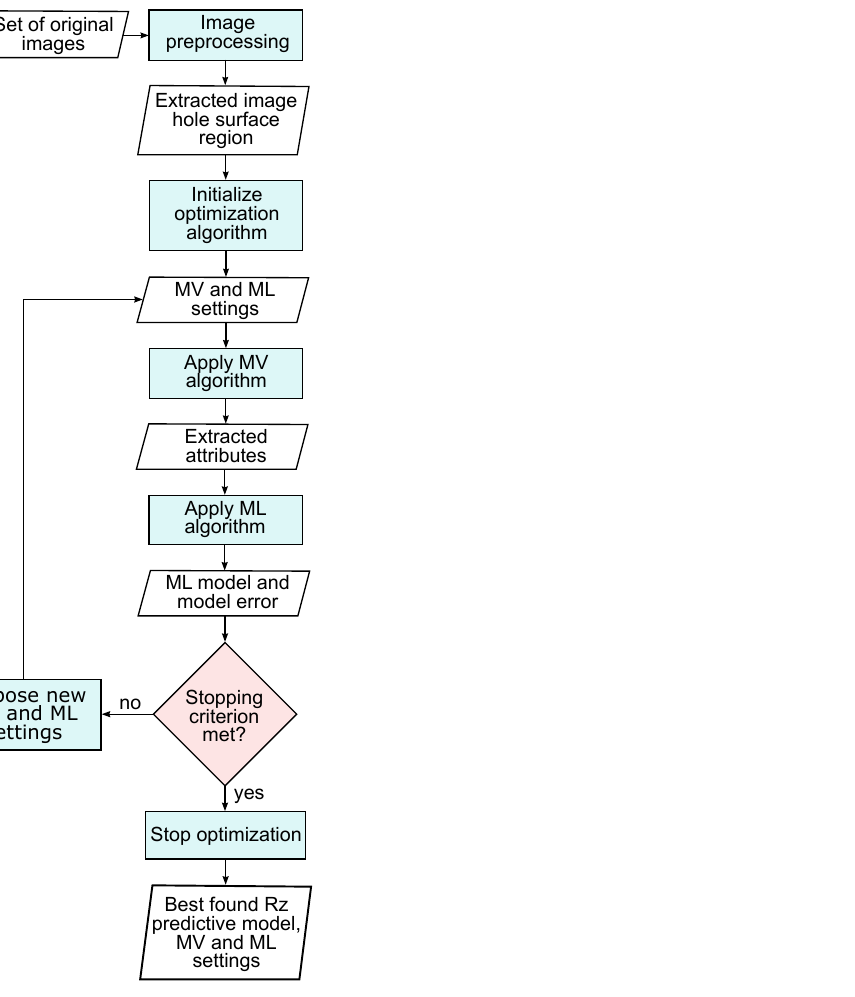
Figure 7. Optimization procedure that searches for the best MV and ML algorithm settings and outputs the best R z predictive